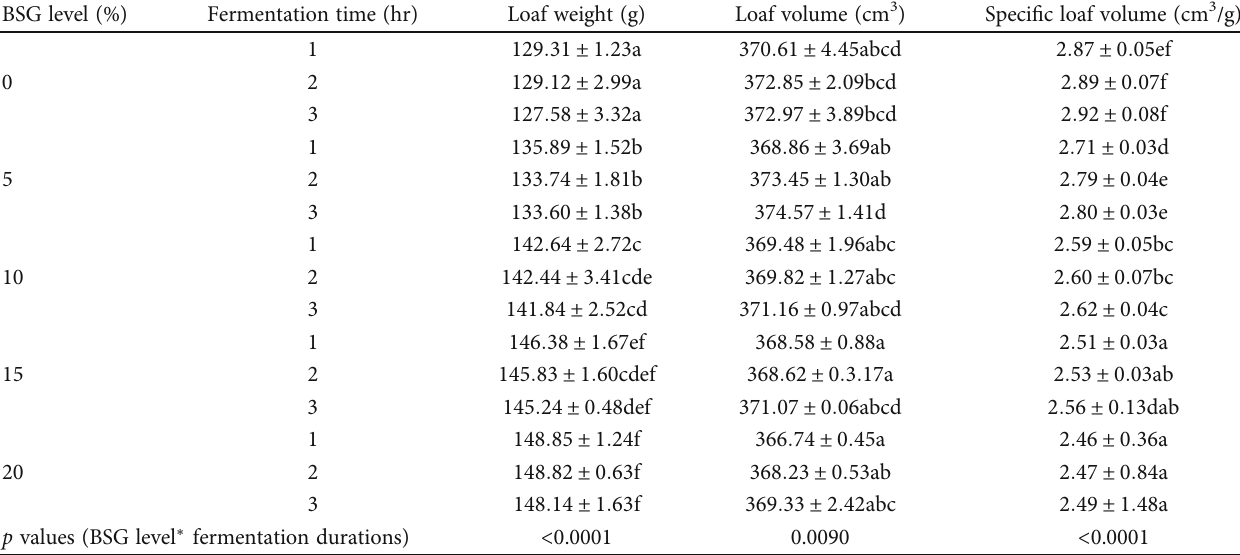
Table 3: Physical properties of the bread prepared with di ff erent levels of BSG and fermentation